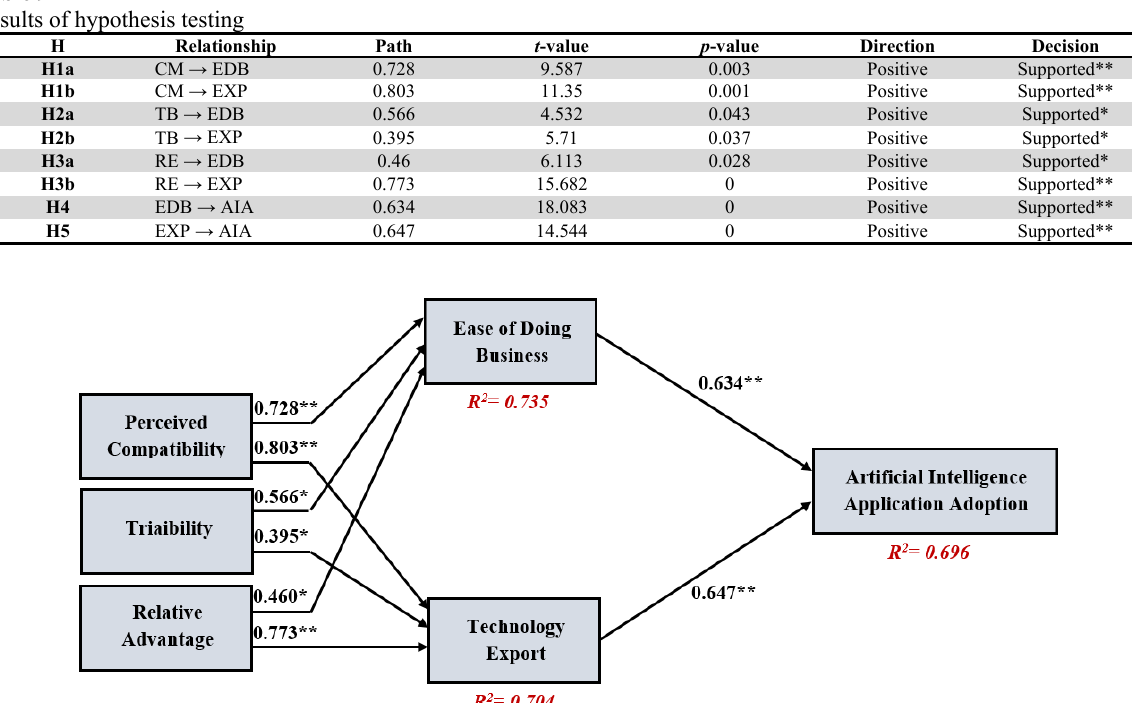
Fig. 2. Path test of the research model ( Note. * p <.05 ** p